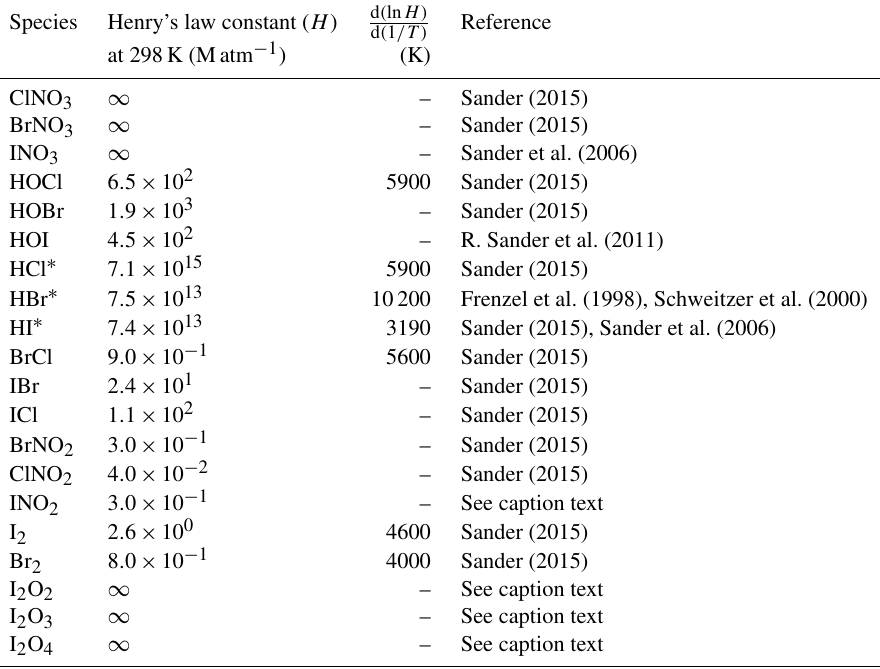
Table 1. Henry’s law constant for relevant halogen species implemented in WRF-Chem. INO 2 Henry’s law constant is assumed equal to that of BrNO 2 . Iodine oxide (I 2 O x ) Henry’s law constants are assumed to be infinity by analogy with INO 3 . Virtually infinity solubility is represented by using a very large number (2 . 69 × 10 15